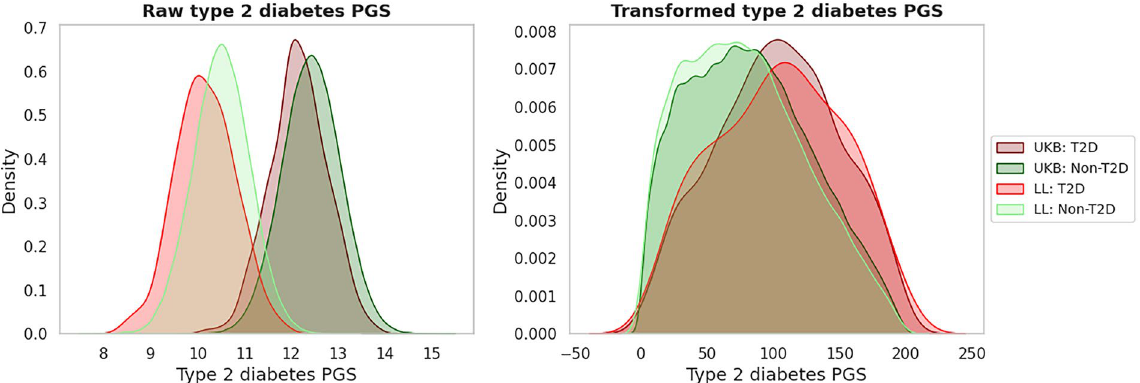
Figure 3. Absolute PGS scores based on different genotyping chips cannot be compared directly. Left: Raw summed PGS scores; Risk scores calculated based on different genotypes are largely different, causing a bias when a risk assessment based one type of chip is compared to a reference cohort based on a different chip. Note that scores for individuals with T2D are lower than those without T2D as the calculated PGS scores capture the protection against T2D (can be multiplied by − 1 to indicate sensitivity for T2D rather than protection). Right: Raw PGS scores were compared to raw PGS scores of the individuals of the 1000 g cohort to translate them into percentiles. This was done for both PGS scores (based on GWAS summary statistic file including variants with p-value threshold 0.01 and 10 –6 ). Then the percentiles where summed and the densities plotted. Raw PGS scores UKB diabetes versus Lifelines diabetes are statistically significantly different (p-value < 10 –323 , Mann–Whitney U test test), but summed PGS for UKB diabetes versus Lifelines diabetes are not (p-value: 0.51, two sided Mann– Whitney U test t-test). PGS Polygenic Risk